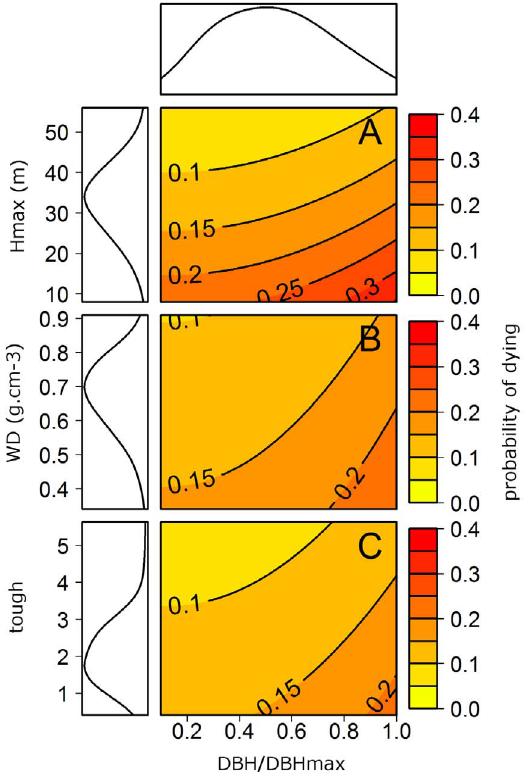
Figure 6. The probability of dying depends on the individual ontogenetic stage and on tree functional traits: the maximum height, Hmax; the wood density, WD; and the laminar toughness, tough. Simulation of the probability of dying versus the DBH ) of the tree, with variation of the three ontogenetic stage ( DBH max continuous functional traits selected in the final model: A the maximum height, B the wood density and C the laminar toughness. Marginal DBH densities are plotted for each trait and for , with a bandwidth DBH max equal to 10% of the amplitude. Density for laminar toughness (C) shows that maximal values (above 3) are rare; variation of mortality due to this trait is not as strong as the variation due to the maximal height.